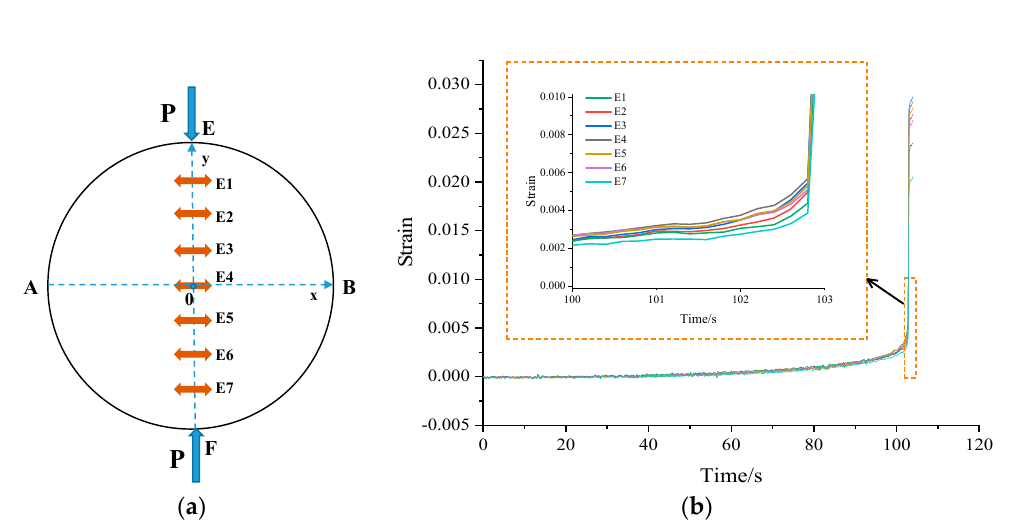
Figure 6. ( a ) Seven virtual extensometers assigned equally along the loading diameter; ( b ) the lateral strains history during the loading process.